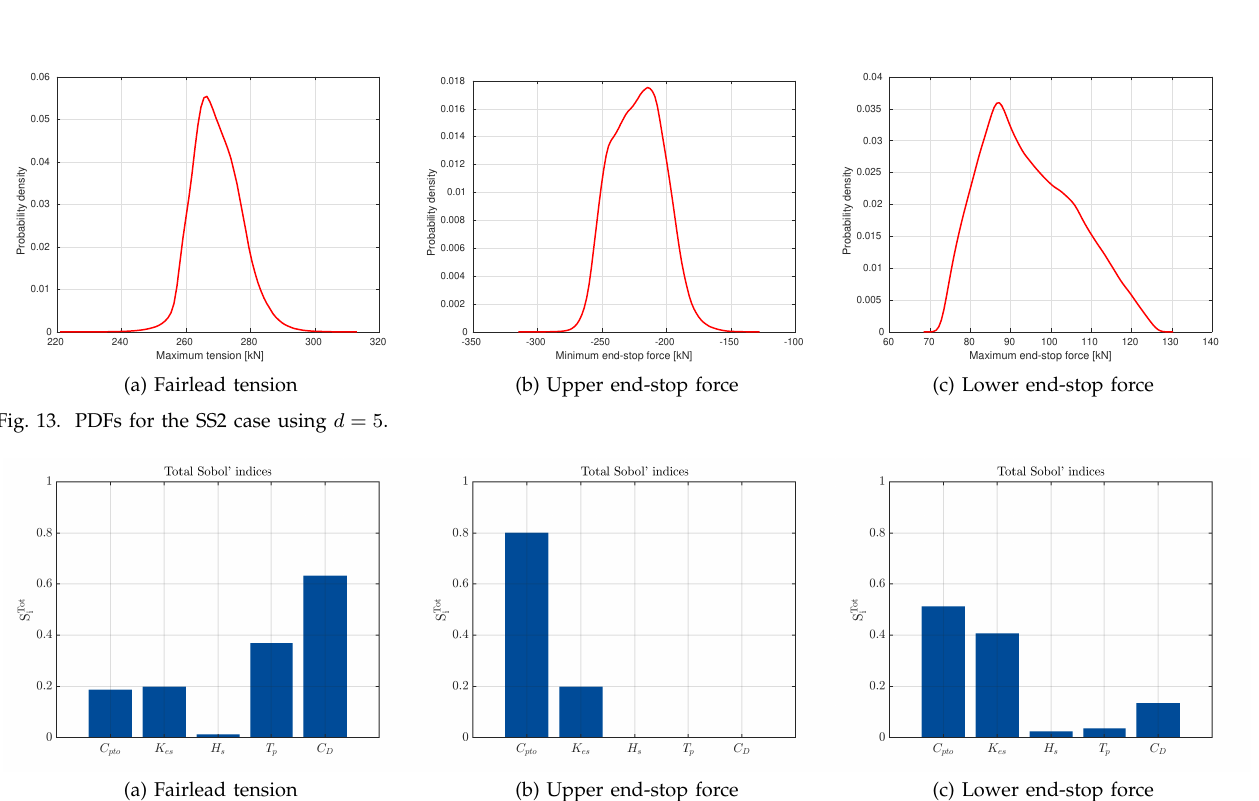
Fig. 14. Total sensitivity index for the SS2 case using d = 5